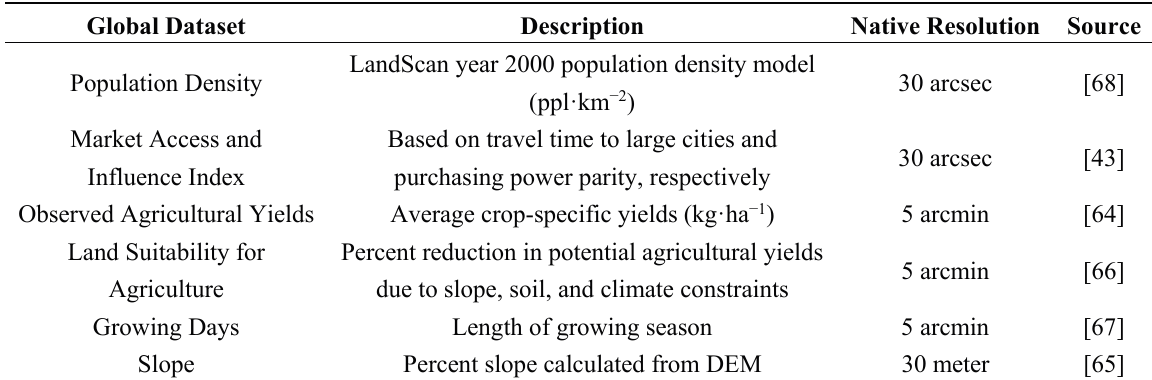
Table 2. Global datasets used as inputs to parameterize the model environment for each test